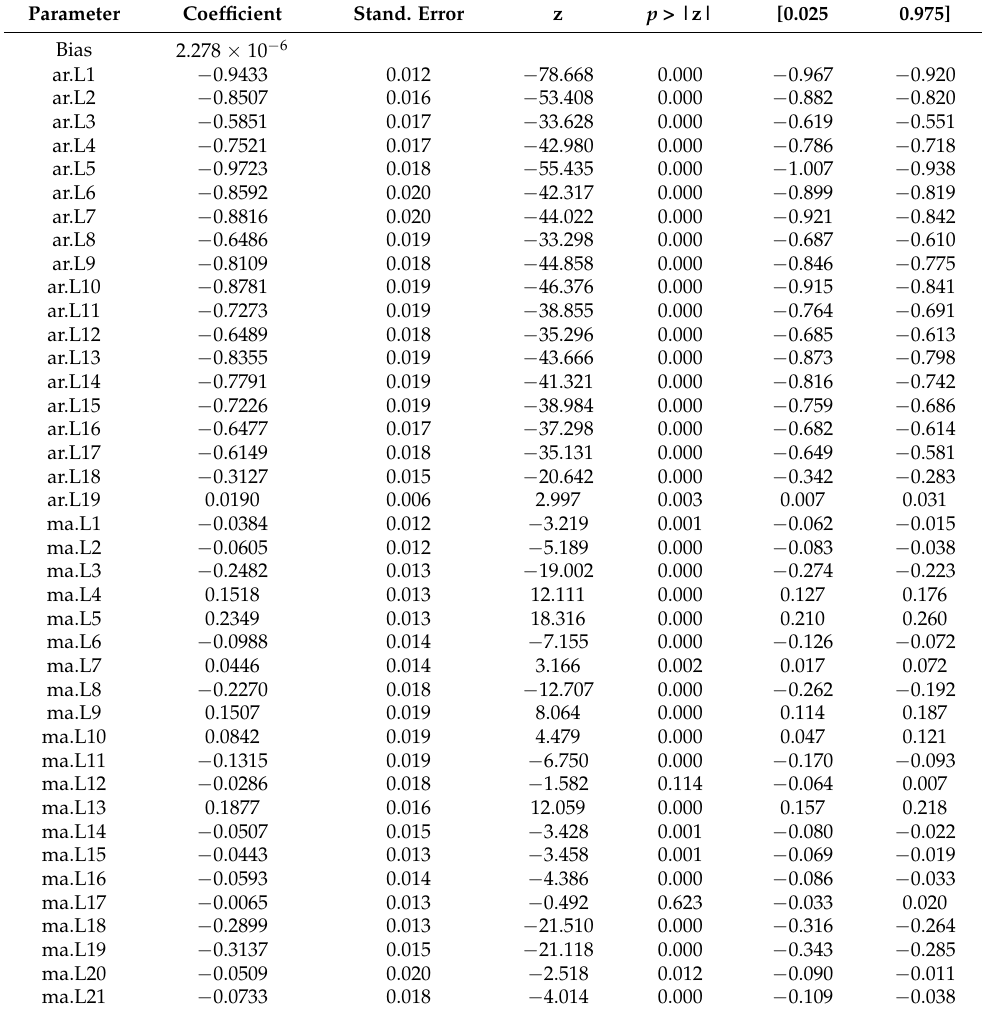
their statistical characteristics. Processed Python 3.4 (Appendix